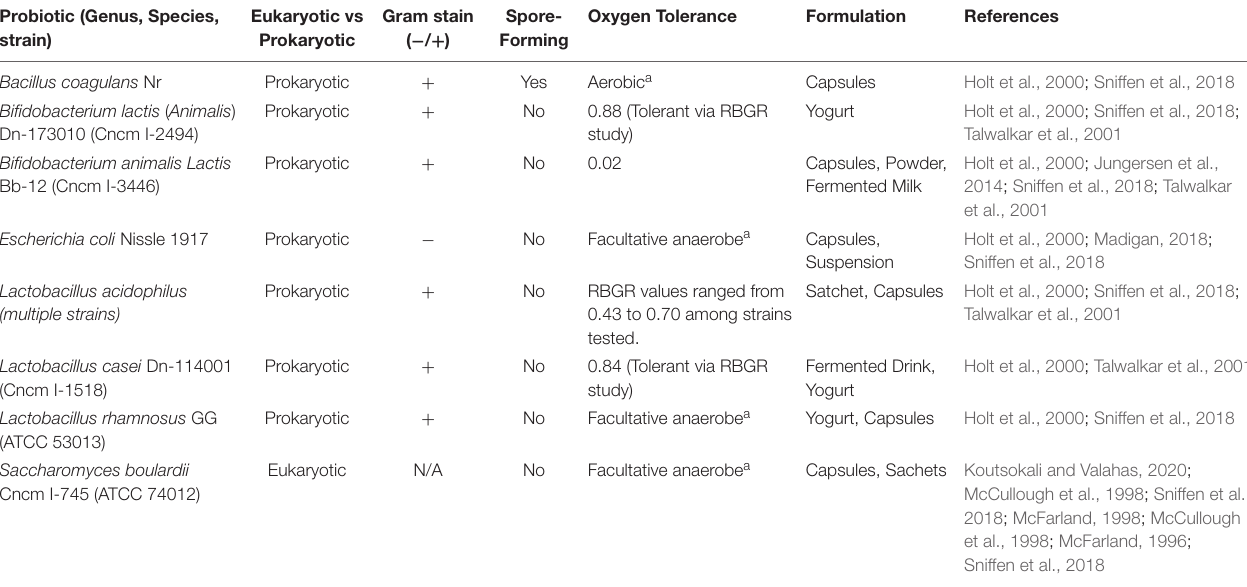
TABLE 1 | Selected probiotic products used in the commercial